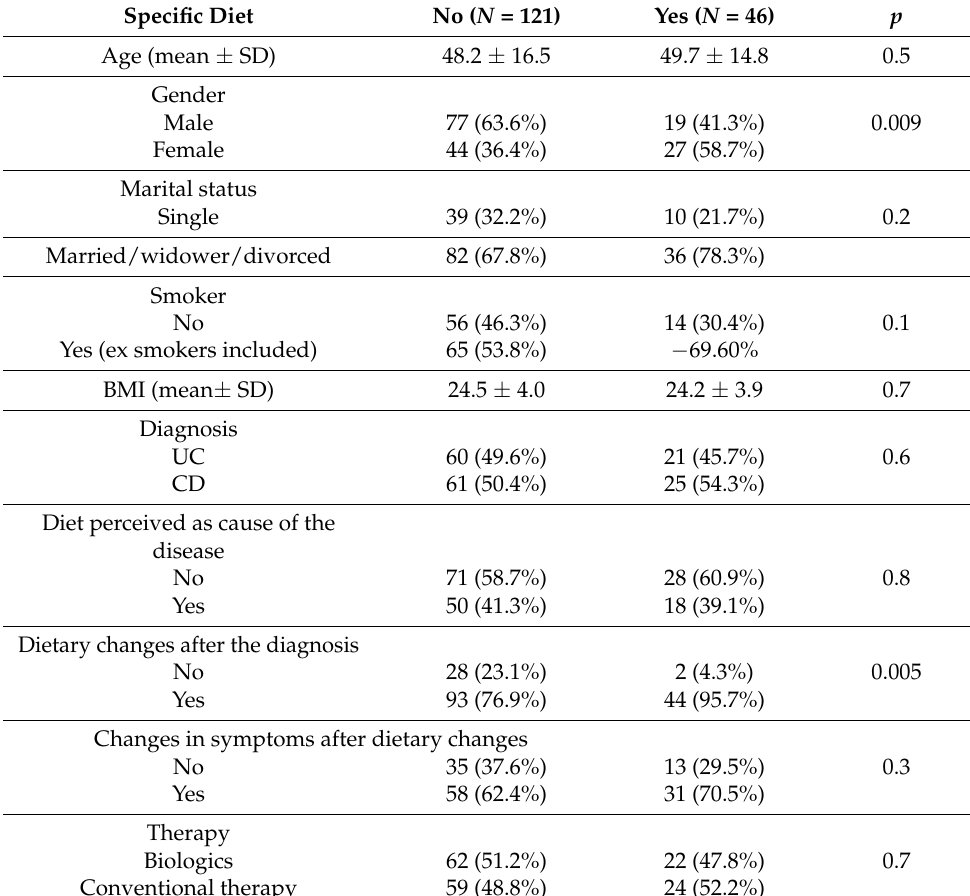
Table 5. Comparison between patients who adopted specific diets and those who did